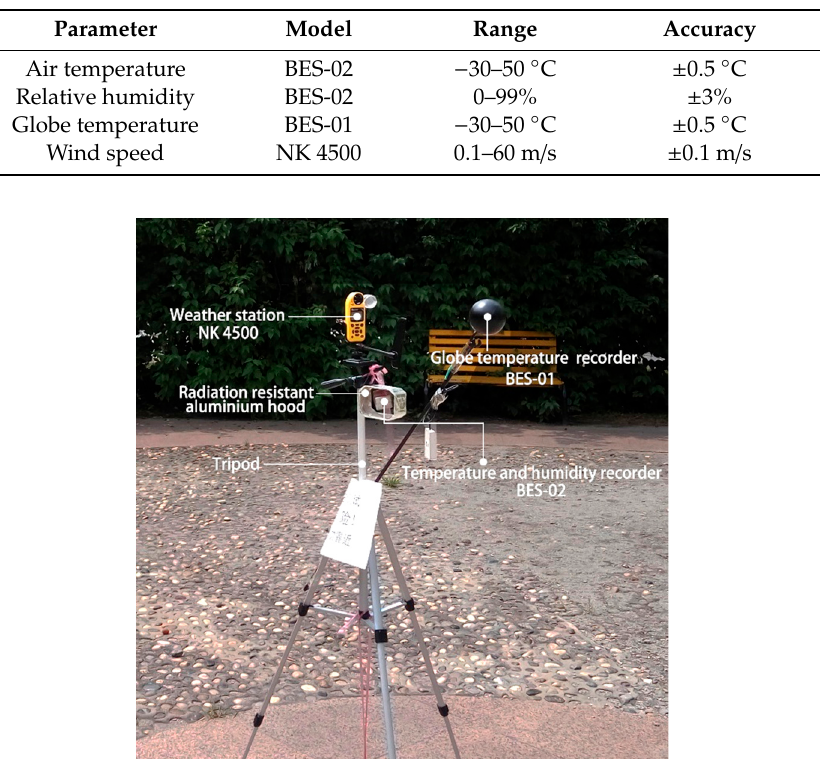
Figure 4. Photograph of the measurement instruments.